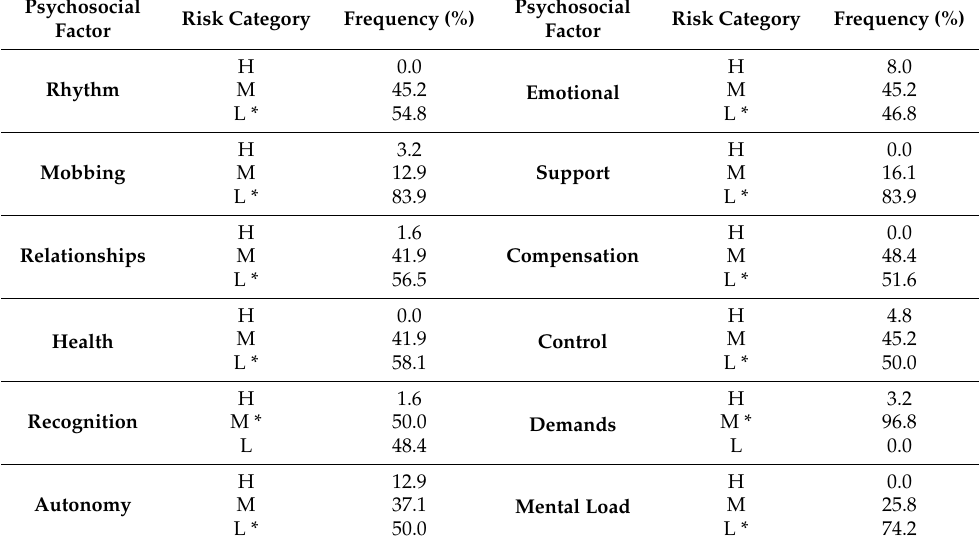
Table 4. Frequency and mode for the different risk categories of the psychosocial factors evaluated by MPF for Almerian greenhouse construction